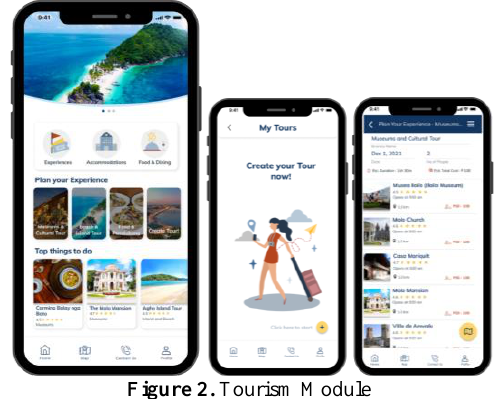
Figure 2. Tourism Module